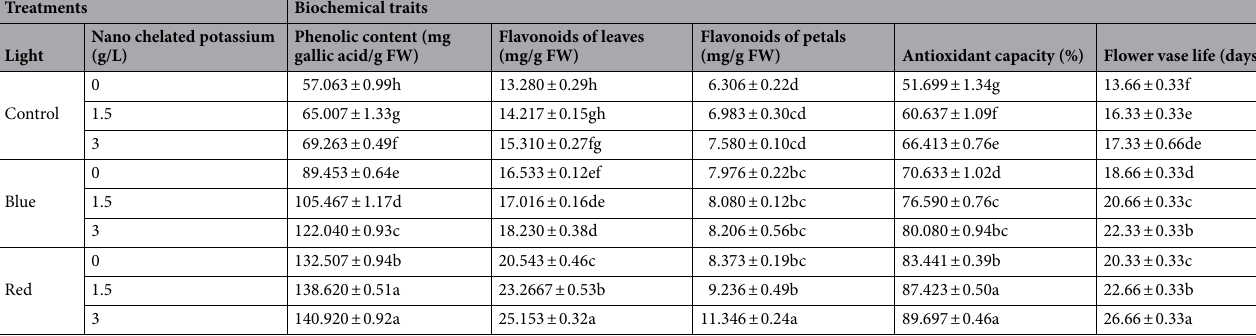
Table 3. The biochemical traits and vase life of cut Dolce Vita rose in response to light and nano-chelated potassium